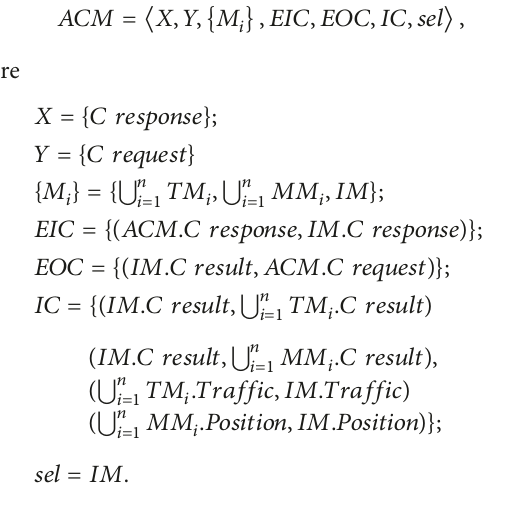
and the neural network and proceeds with the simula-